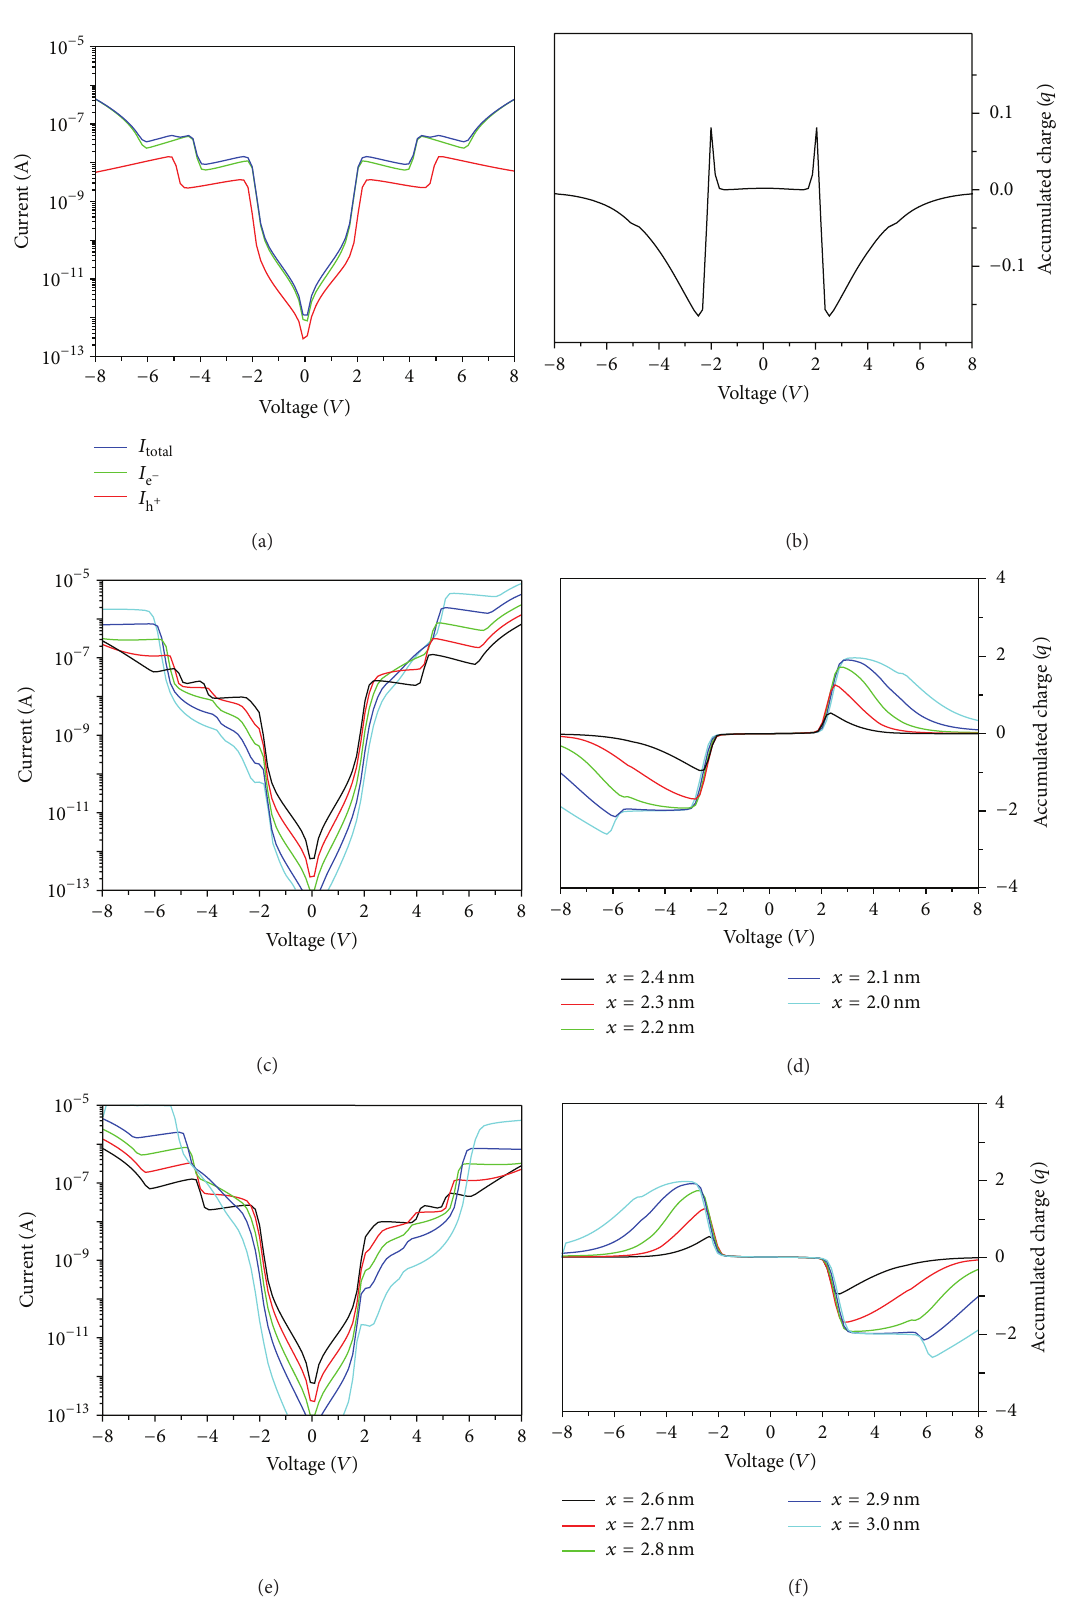
Figure 5: A single Si/SiO 2 Qd of 𝑅 = 1.5 nm placed in different positions between the two leads. 𝑥 is the distance from the left lead to the center of the Qd. The separation among the leads is 5nm. ((a)-(b)) 𝐼(𝑉) curve and accumulated charge for a centered Qd. The hole and electron currents are also shown. ((c)–(e)) 𝐼(𝑉) curves for different Qd positions and ((e)-(f)) accumulated charge in the same